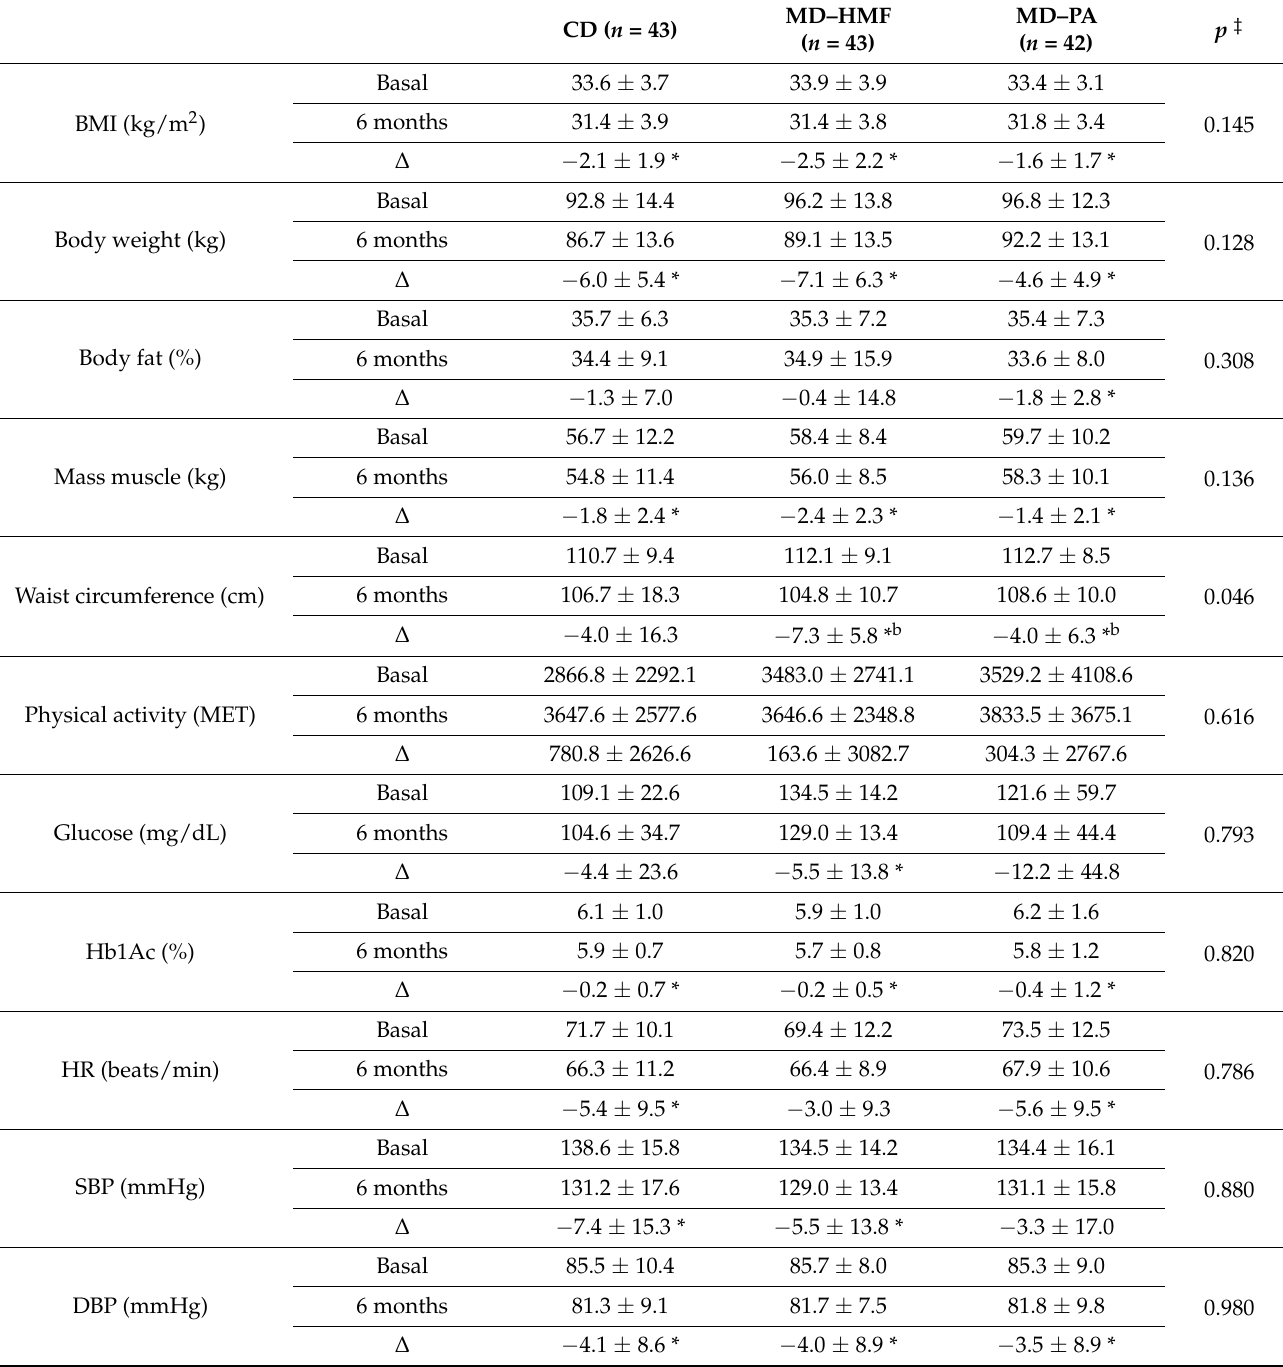
Table 2. Changes in 6 months of anthropometric, metabolic, and liver parameters after 6 months of